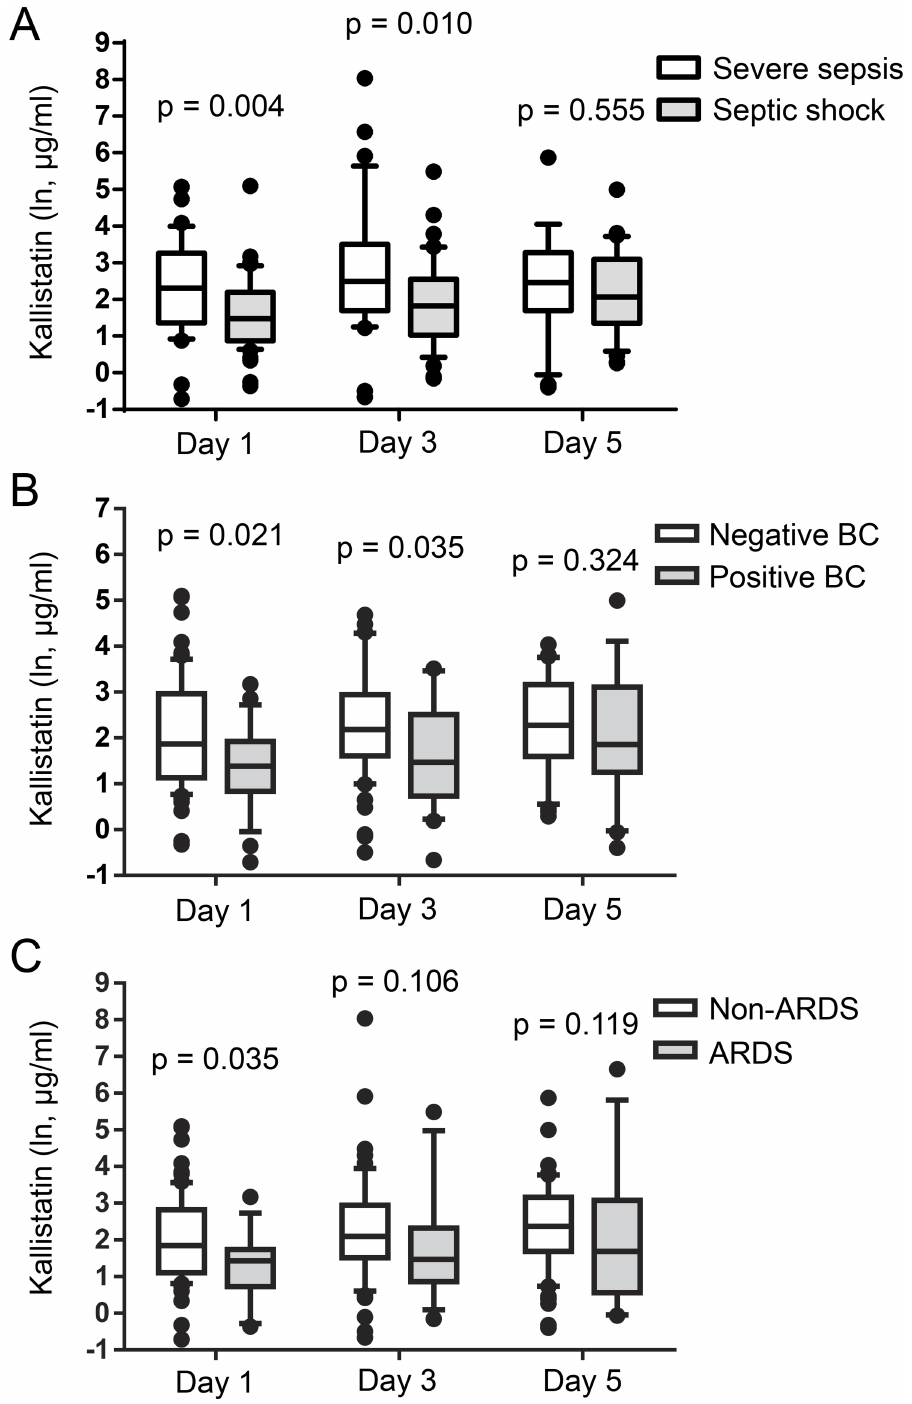
Fig 2. Plasma kallistatin levels on days 1, 3 and 5 of ICU admission in severesepsis versus septic shock, positive blood culture versus negative blood culture, and ARDS versus non-ARDS. Plasma kallistatinlevels on days 1, 3 and 5 were comparedbetweenpatients with severe sepsis and septic shock (A), patients who were blood culture positive and bloodculture negative(B), and ARDS and non-ARDS patients (C). The Mann-Whitney nonparametric U -test was used for comparisons betweenthe groups. BC, blood culture.